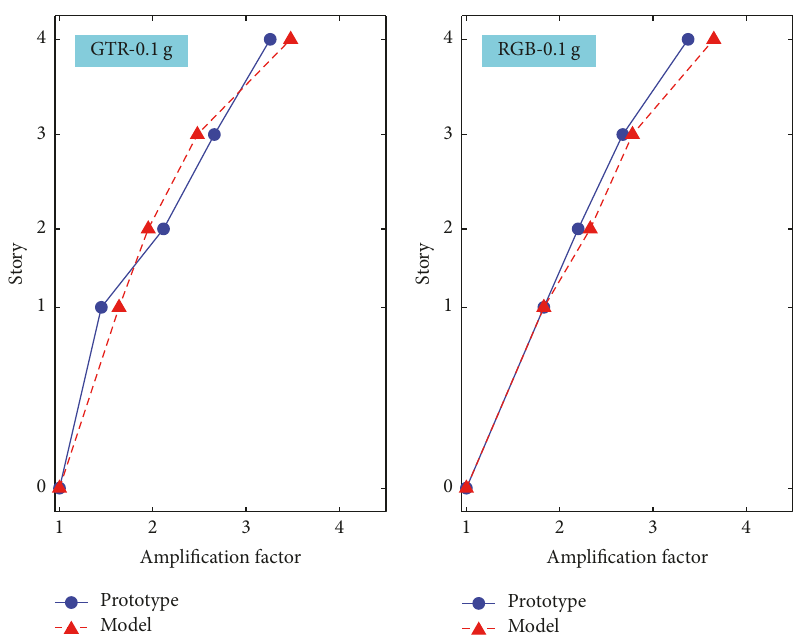
Figure 17: Amplification factor of the prototype structure and test model structure under frequent earthquakes.